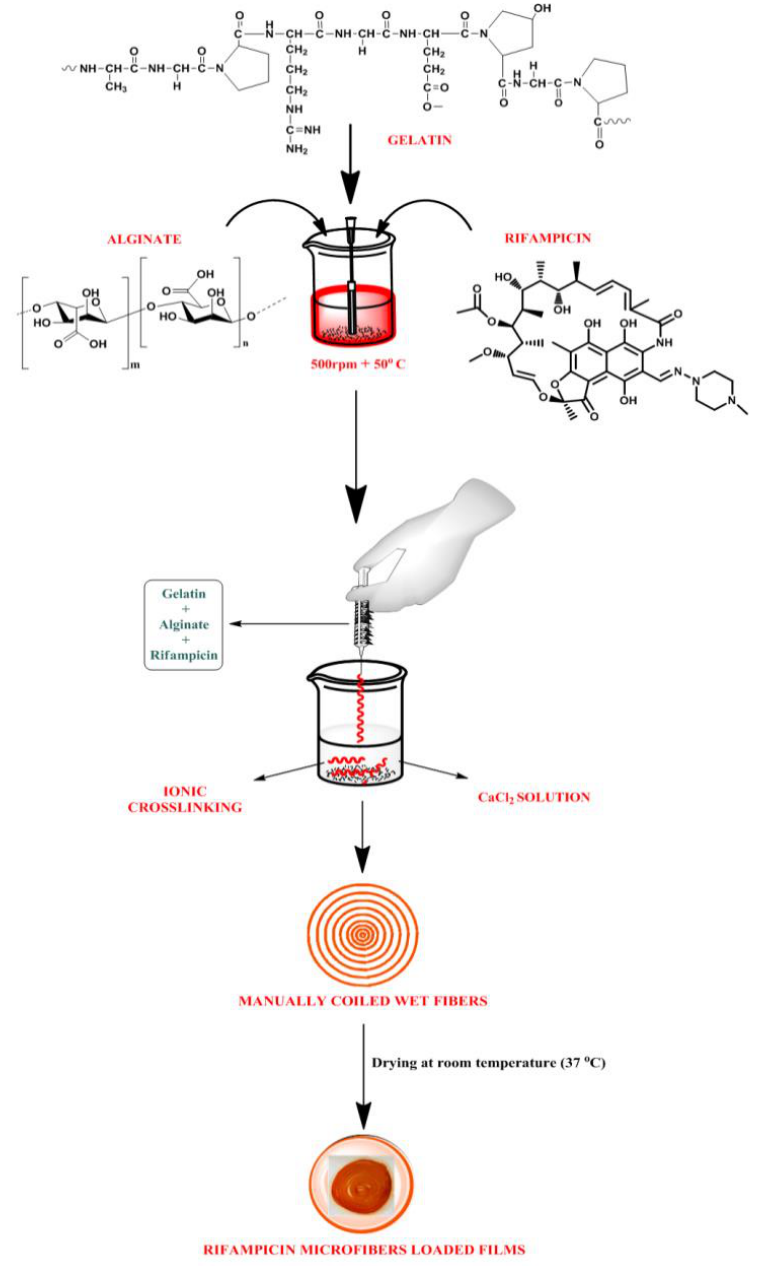
Figure 1. Fabrication method of rifampicin fiber-loaded transdermal films.